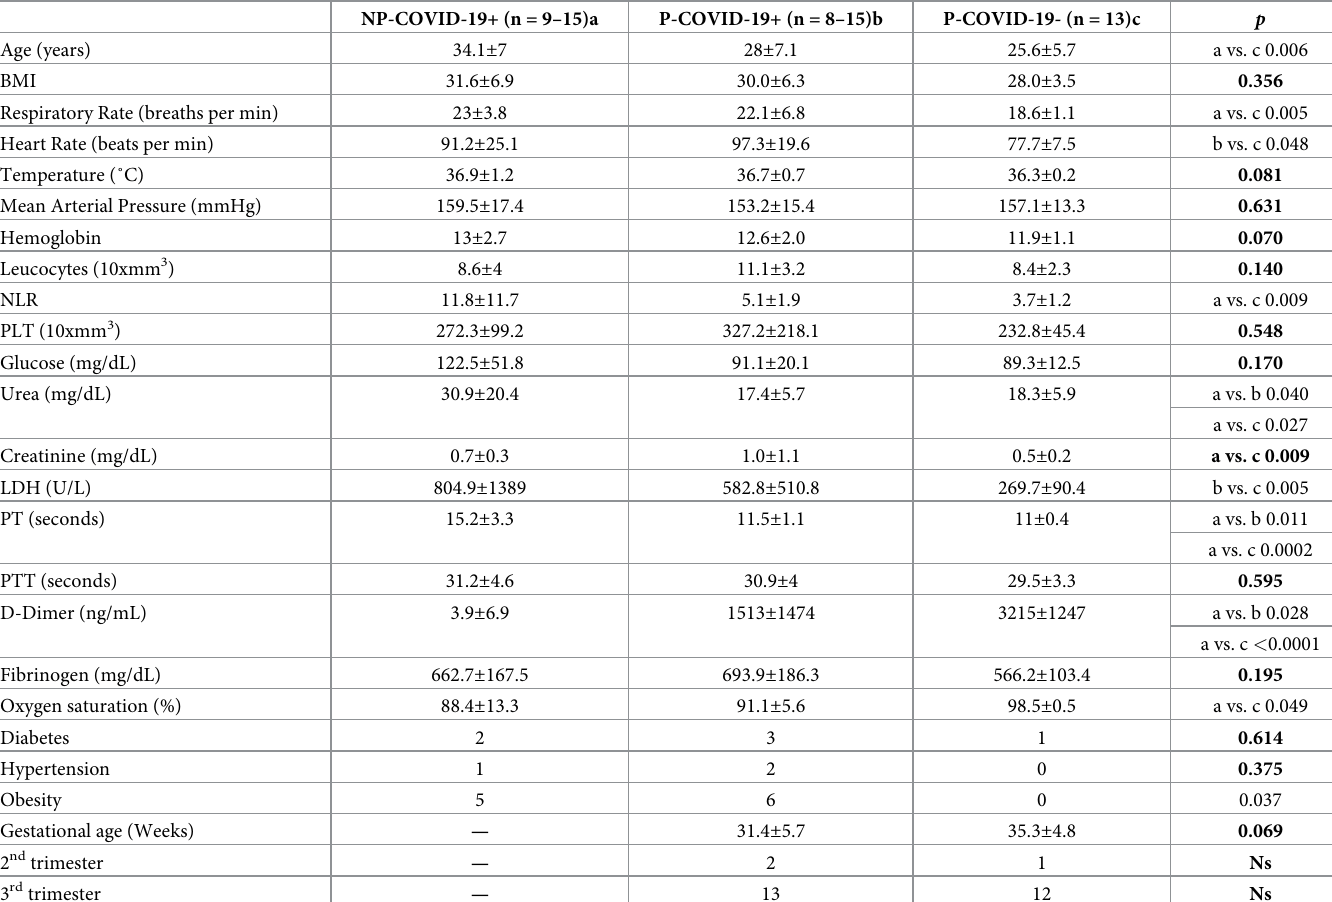
Table 1. Clinical and laboratory